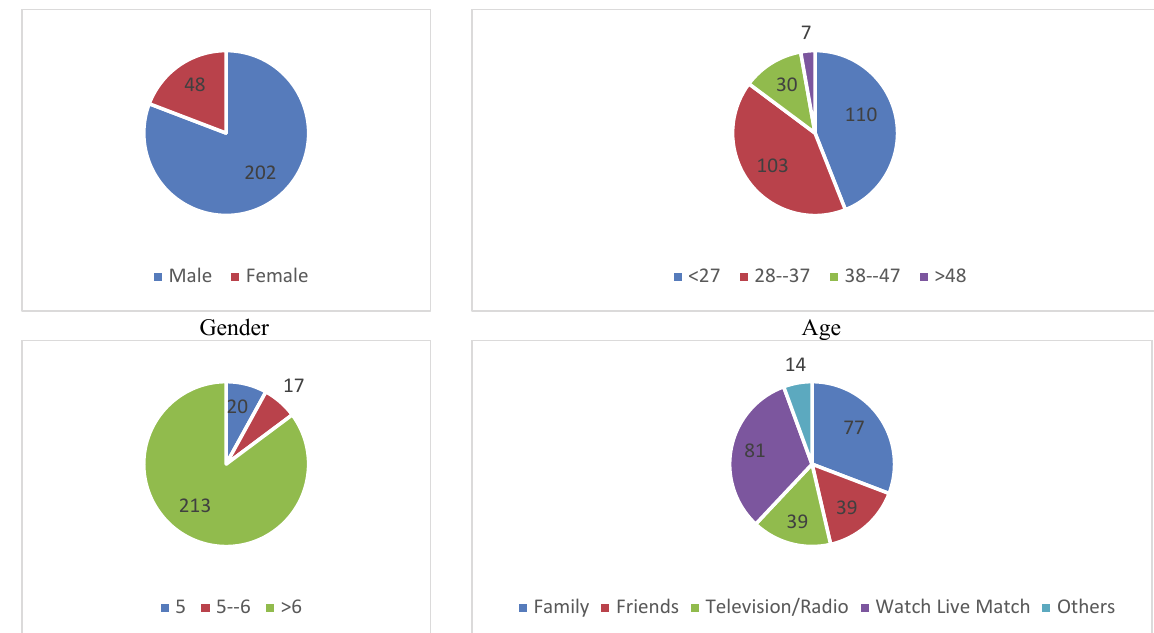
Fig. 2. Respondent